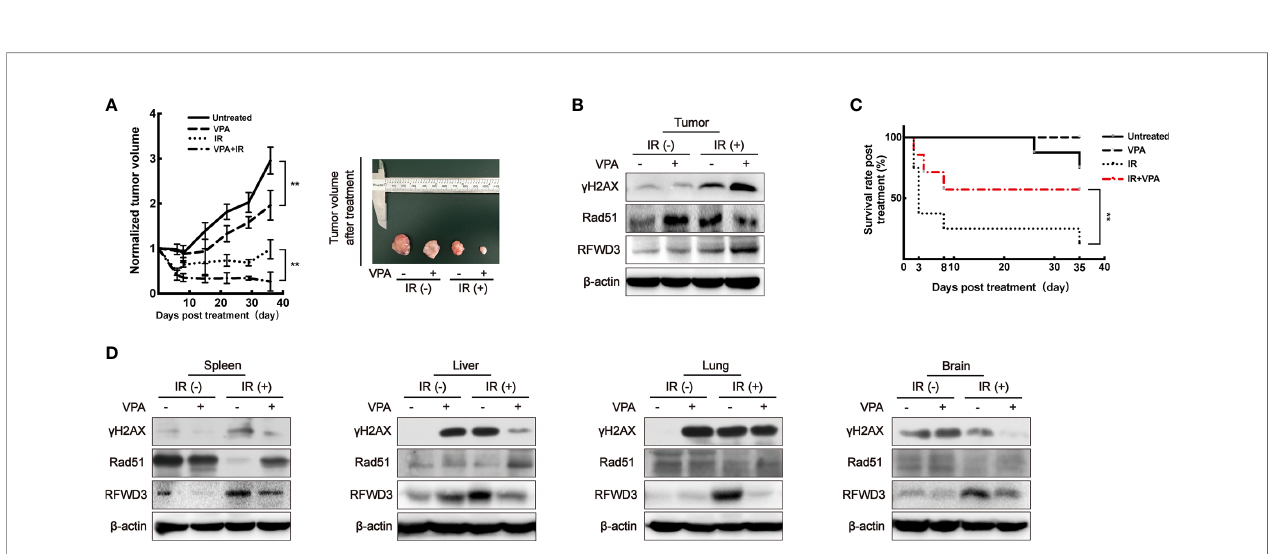
FIGURE 5 | VPA targets RFWD3 for bidirectional regulation on HR activity in vivo . (A) Left panel: tumor volume of DMBA-induced primary breast cancer rats after treatment was normalized by the untreated group (n = 10 in each group). Right panel: tumors dissected from rats at the 35th day post-treatment. (B) Protein expression in tumor tissue was detected by speci fi c antibodies through Western blot. (C) The survival rate of tumor rats following VPA and IR treatment (n = 10 in each group). (D) Proteins expression in normal tissues under VPA or IR were detected by speci fi c antibodies through Western blot. Bands in the fi gures were quanti fi ed by ImageJ software (Wayne Rasband); each data point in the graph was from three independent experiments (mean ± SD); P -values were calculated by t-test (** P <